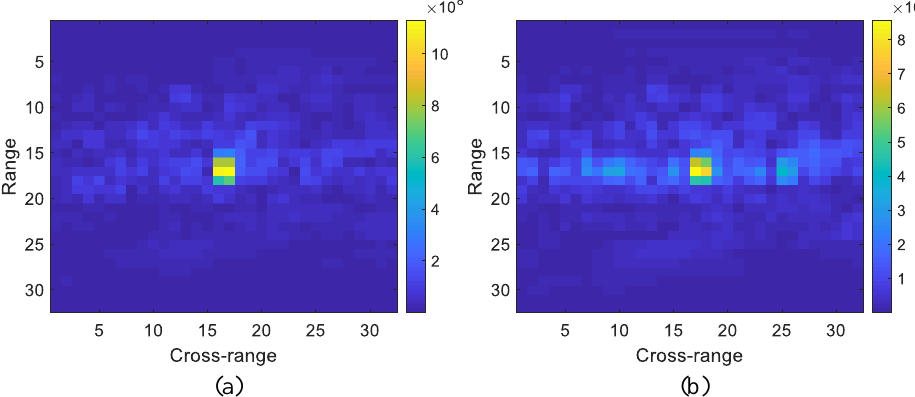
Figure 13. The imaging result of T2. ( a ) HPC-GMTIm (entropy = 3.62). ( b ) GHHAF method (entropy =